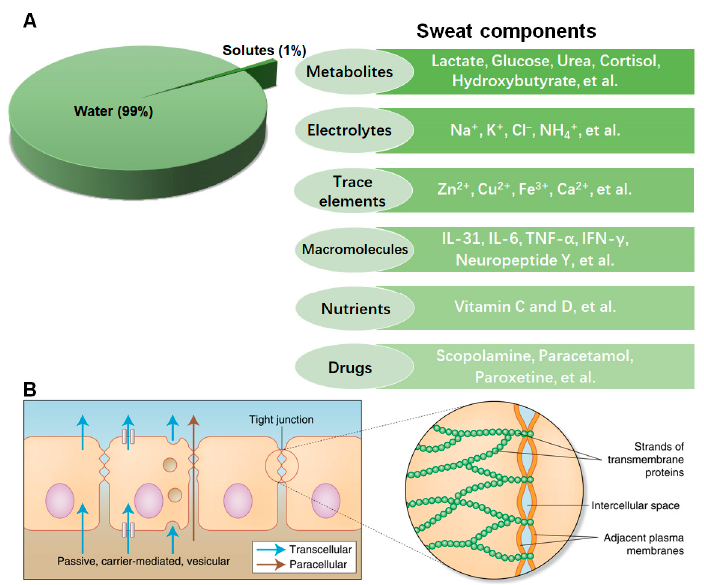
Figure 1. Schematic diagram of ( A ) the sweat components and ( B ) three ways for biomarkers to enter sweat (Reprinted with permission from Ref. [43]. Copyright 2019, Springer). One way is by diffusion through the plasma membrane of capillary endothelial cells; the other is diffusion or advection transport between cells; and the third is transport through cell